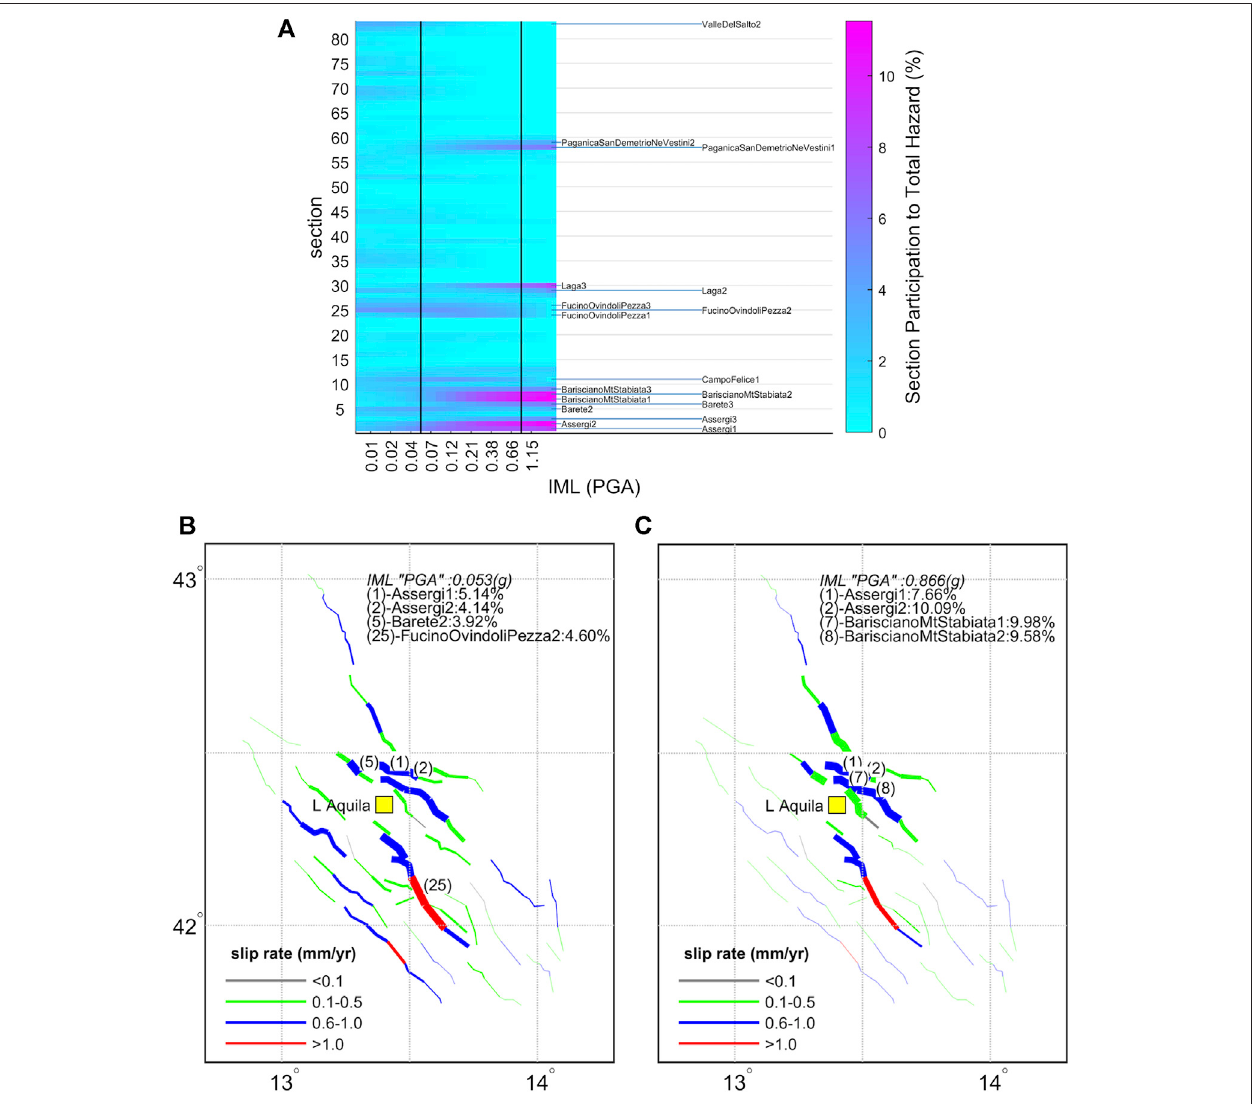
FIGURE8| ParticipationofMF-sectionstotheseismichazardatL ’ Aquila(YellowSquare): (A) MF-sectionparticipationdiagrams(%oftotalhazard)asafunctionof the PGA. Vertical lines correspond to the PGA example values used in (B) and (C) frames, respectively. Maps of MF-sections contributing to the exceedance of a PGA value of (B) 0.053 g and (C) 0.866 g. MF-sections are color-coded according to the slip rate class and their width corresponds to their percentage participation to exceeding given PGA value at L ’ Aquila. Only MF-sections participating the most to the total hazard (the upper 10% of the distribution) are labelled.